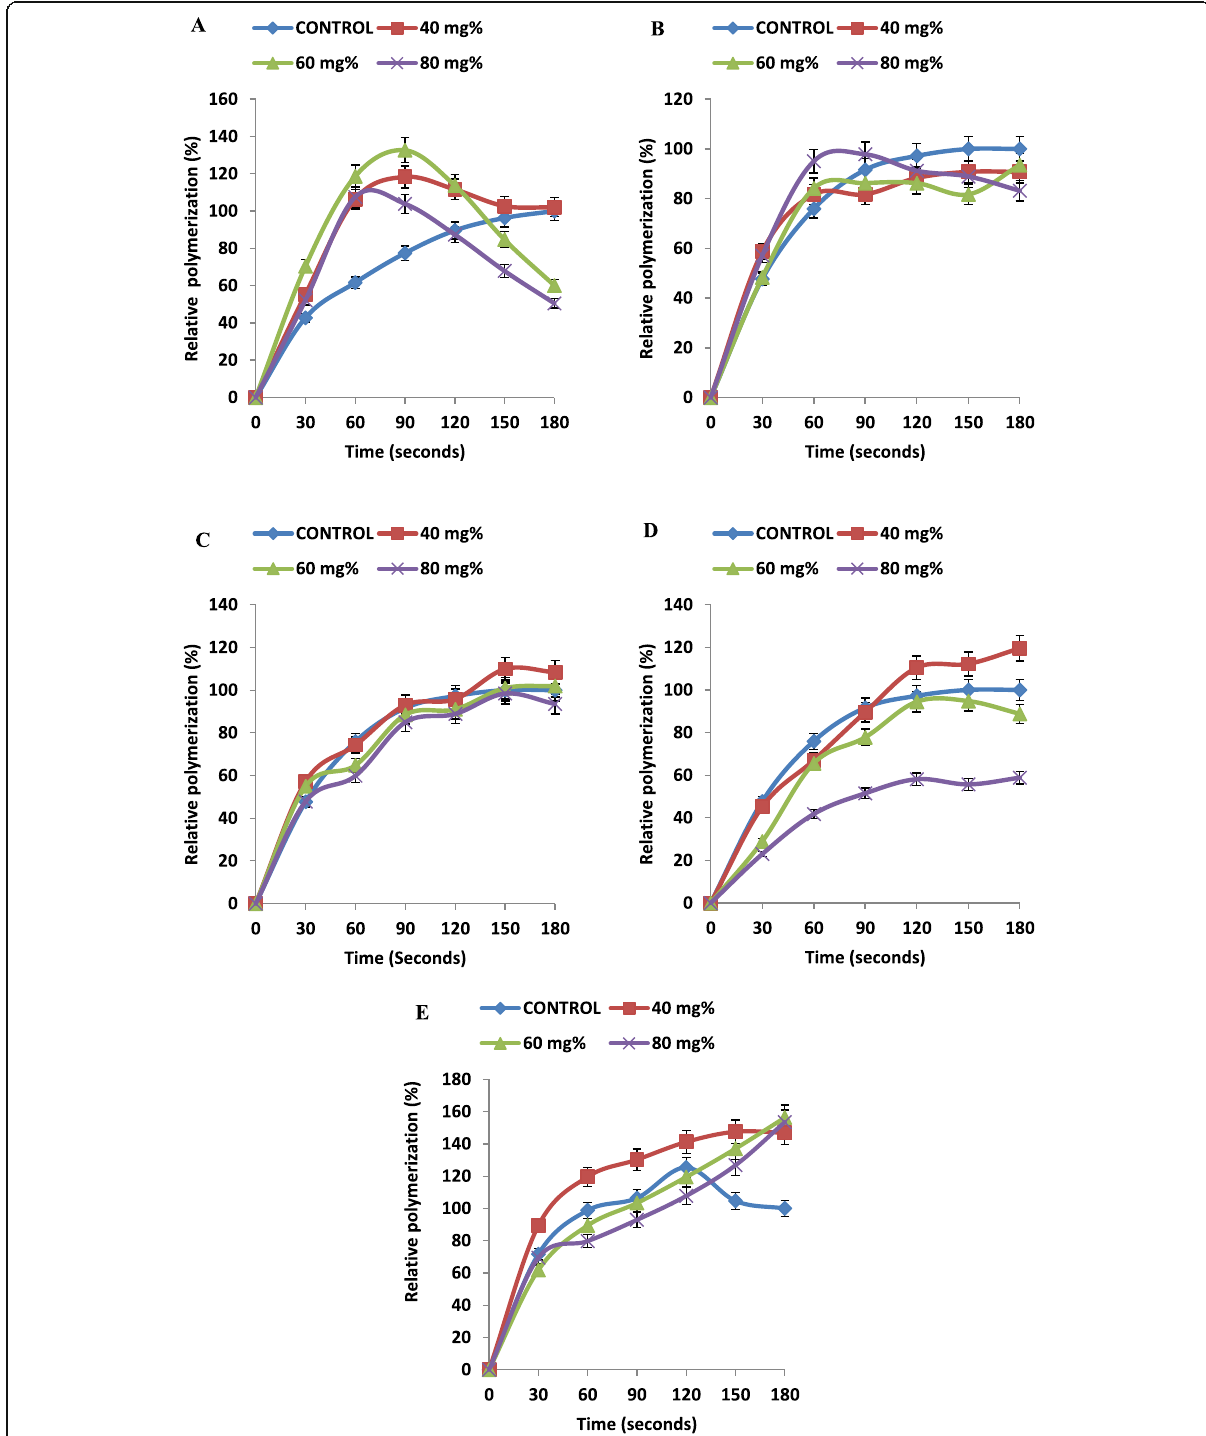
Fig. 3 Comparative levels of poly-dHbS-M of control sample and in the presence of fractionated leaf extracts of T . catappa. a Petroleum ether. b n -hexane. c Chloroform. d Ethylacetate. e Residual aqueous; mg% = mg/100